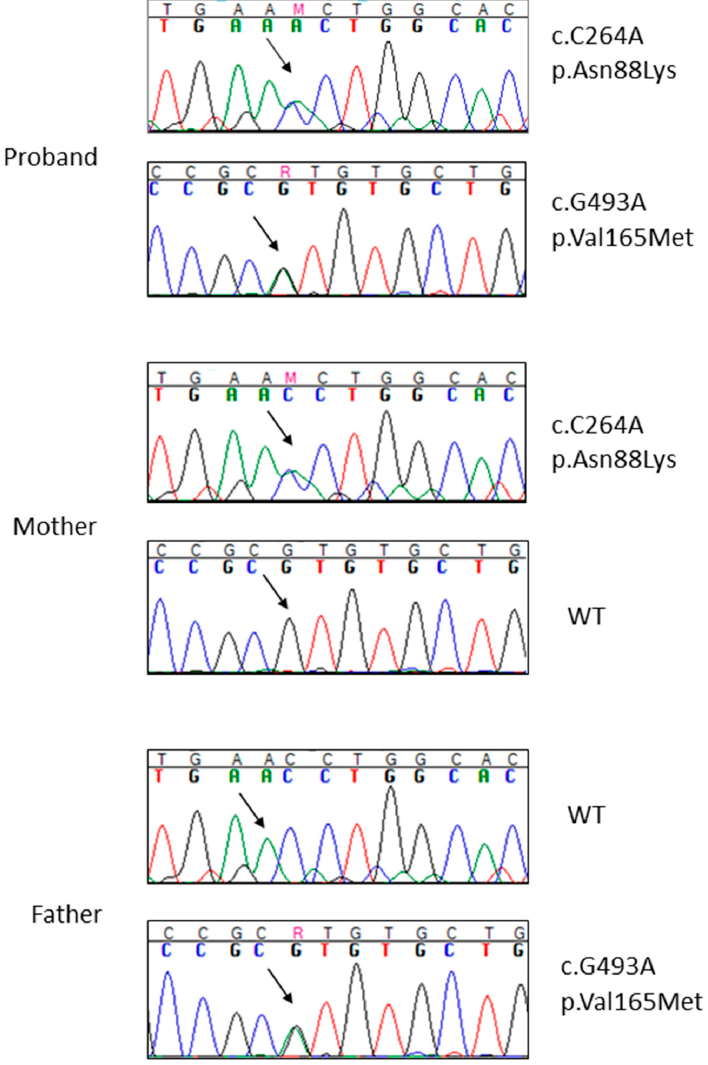
Figure 3. Sanger sequencing of the two RAPSN variants (p.Gln88Lys above and p.Val165Met below ) in the proband and in his parents. The arrows indicate the mutation site. Different colors identify the four different nucleotides (A = green, C = blue, G = black, T = red). Wt = wild type.